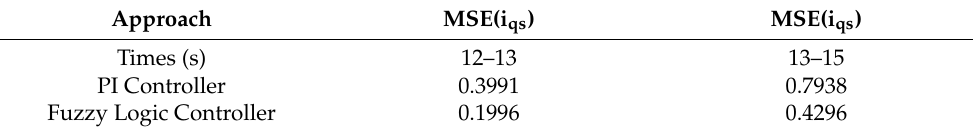
Table 3. Numerical comparison of PI controller and FLC under q -axis